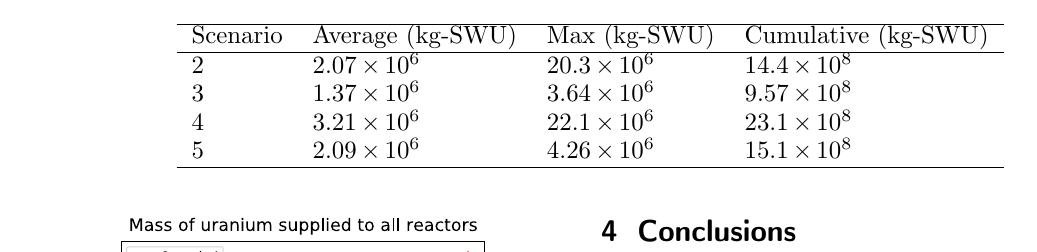
Table 4. Summary of SWU capacity requirements in each transition scenario. Average values are based on when the advanced reactors are first deployed, and the maximum value is for a single time step.